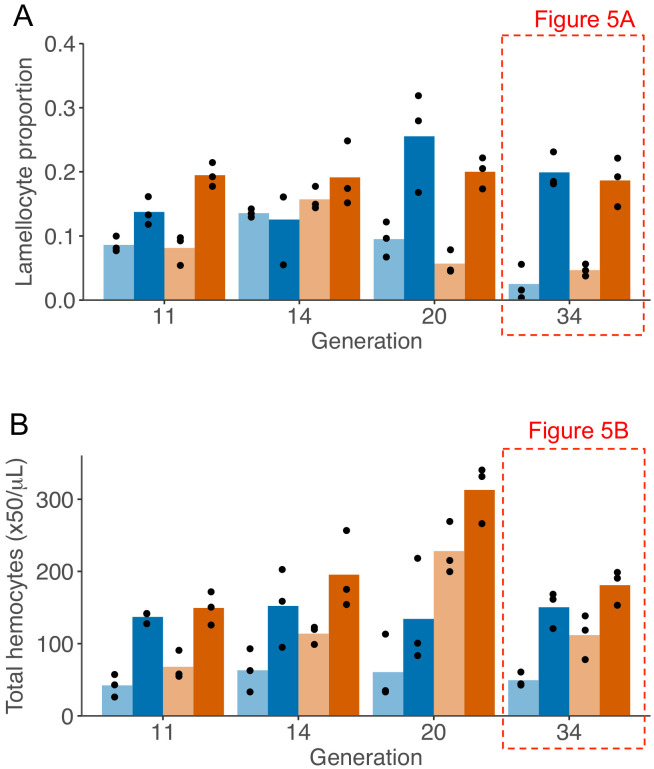
Changes in number of circulating hemocytes during artificial selection.Proportion of lamellocytes (A) and concentration of total circulating hemocytes (B) in population evolved with no parasitism (blue bars) and with high parasitism (orange bars). Samples were collected as late 3rd instar larvae in homeostasis (light colours) or 48-hr post infection (dark colours). Each dot represents the mean counts of each population calculated from 4 to 10 replicas and bar height represents the mean of the triplicate lines. Generation 34 is represented in Figure 5A–B.